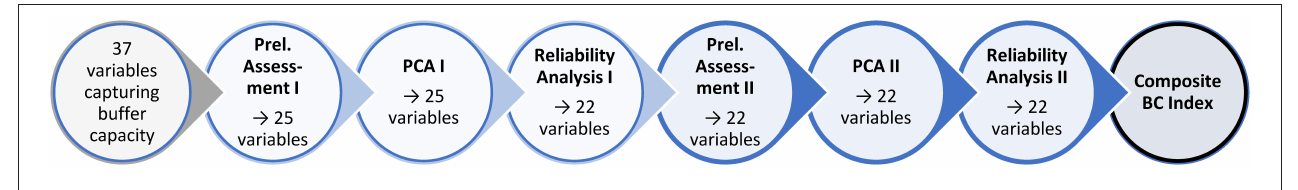
FIGURE 4 | Iterative process and variable exclusion.